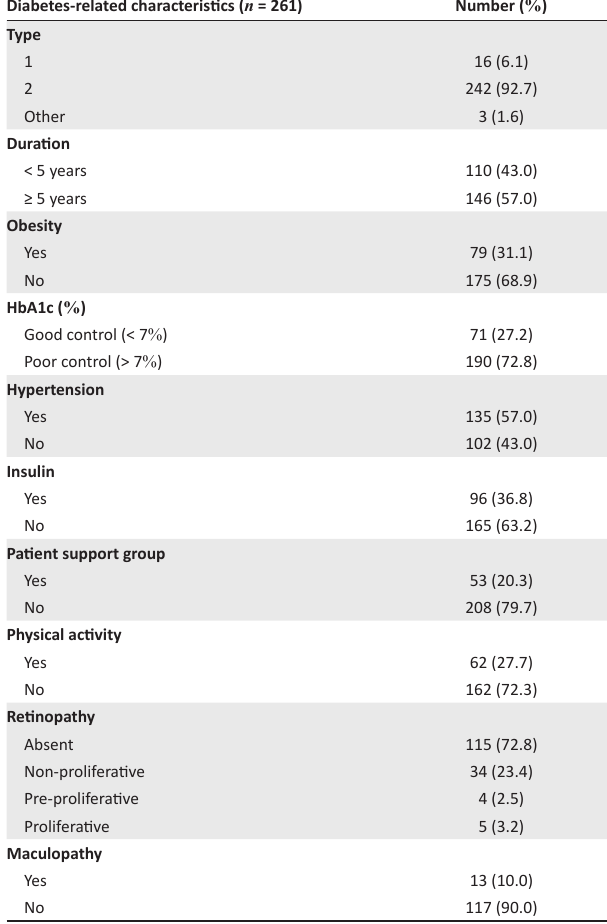
TABLE 2: Diabetes-related categorical characteristics in the study